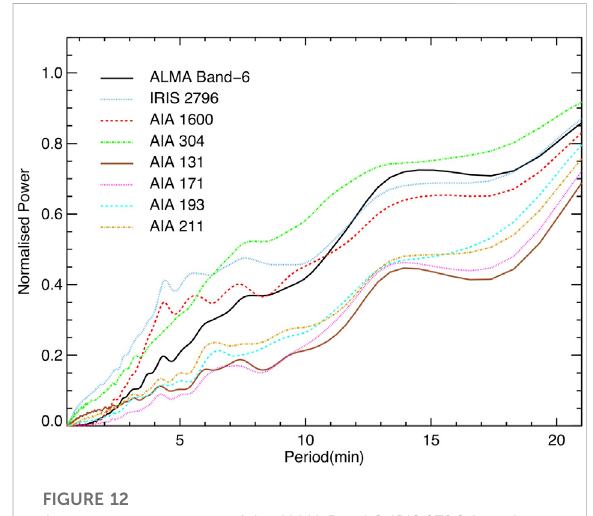
FIGURE 12 Average power spectra of the ALMA Band 6, IRIS 2796 A, and 6 selected AIA passbands in a plage region. From Narang et al. (2022). Reproduced with permission ⓒ ESO.